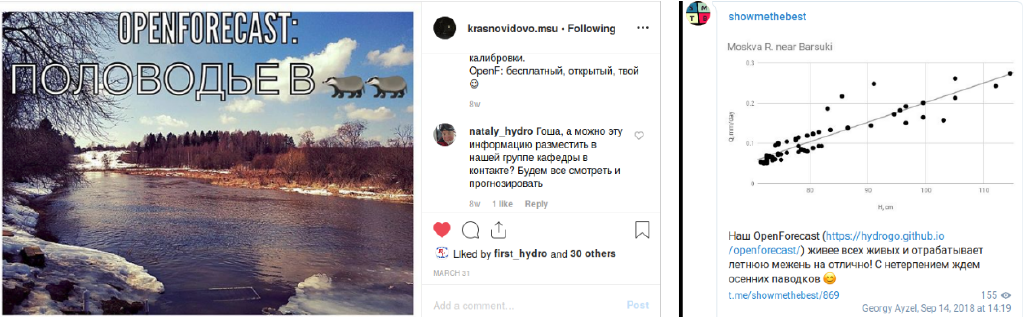
Figure 11. Screenshots of the posts in Instagram ( left plot , https://www.instagram.com/p/ BvrLbBXFT7C/, 31 March 2019) and Telegram ( right plot ,